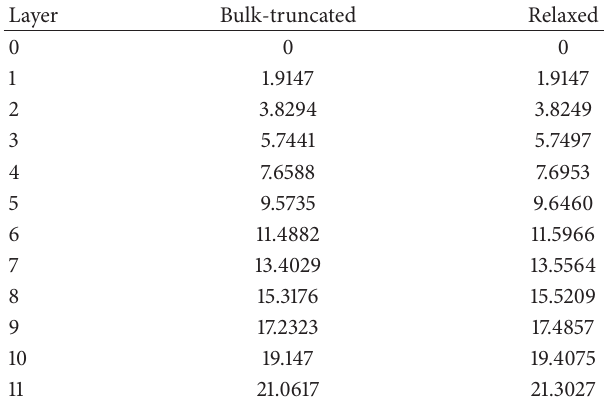
Figure 3: Calculated local electrostatic potential versus normalized distance of (110) surface. The integer number along the horizontal axis is the atomic layer being the bulk-truncated position and 11 is the topmost surface layer. We used 𝑥𝑦 -averaged local electrostatic potential. The relative position of relaxed surface layers is deter- mined by the minimum of the local electrostatic potential. E-Fermi, -Fermi and 𝑉 -Fermi are the Fermi levels of the corresponding O I O surface (bulk-truncated, O interstitial and O vacancy) calculations.